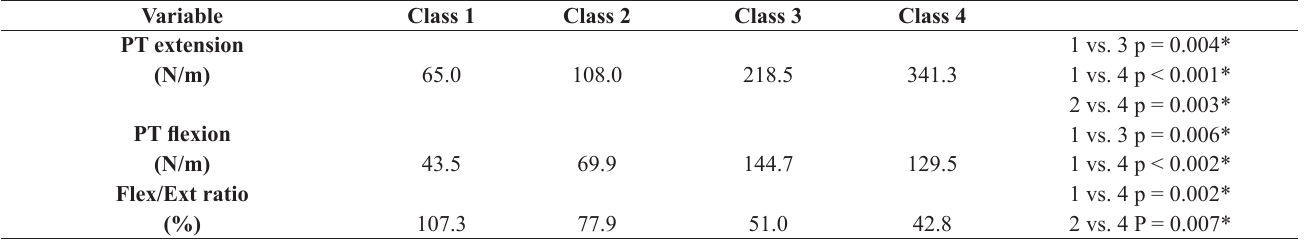
Table 3. Comparison of isokinetic variables of trunk muscle strength according to the WCB classes. Variable